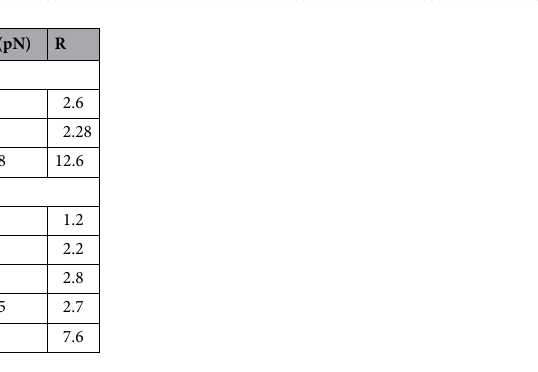
Table 4. The values of f, Q factor, E f , F z , ( F y ) , and R parameters shown in Fig. 5d,f for the hybrid aluminum- PDMS